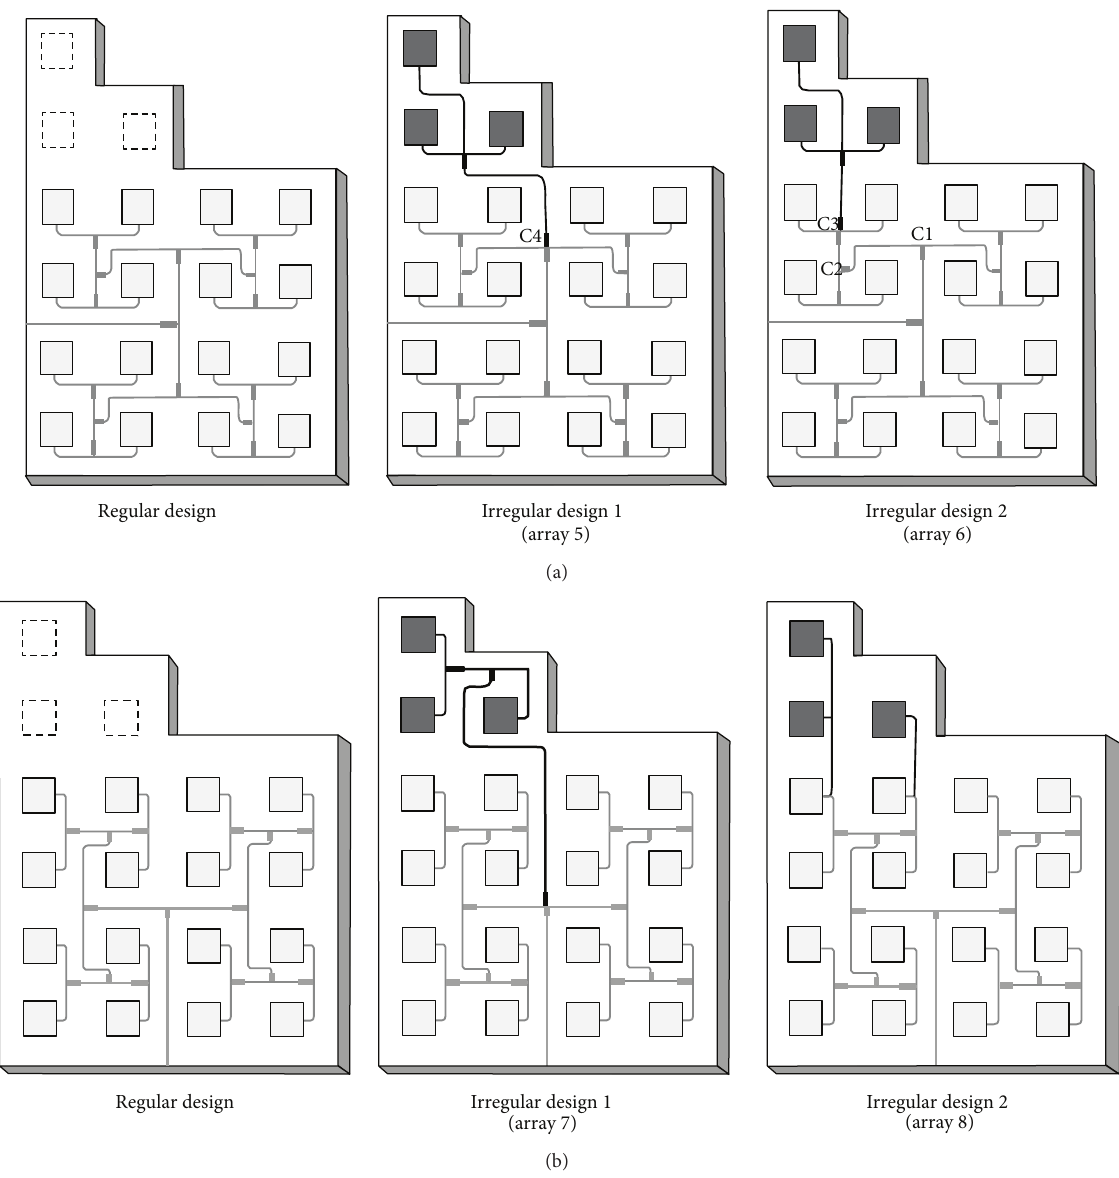
Figure 4: Designs of concave array (a) vertical and (b) horizontal polarization.